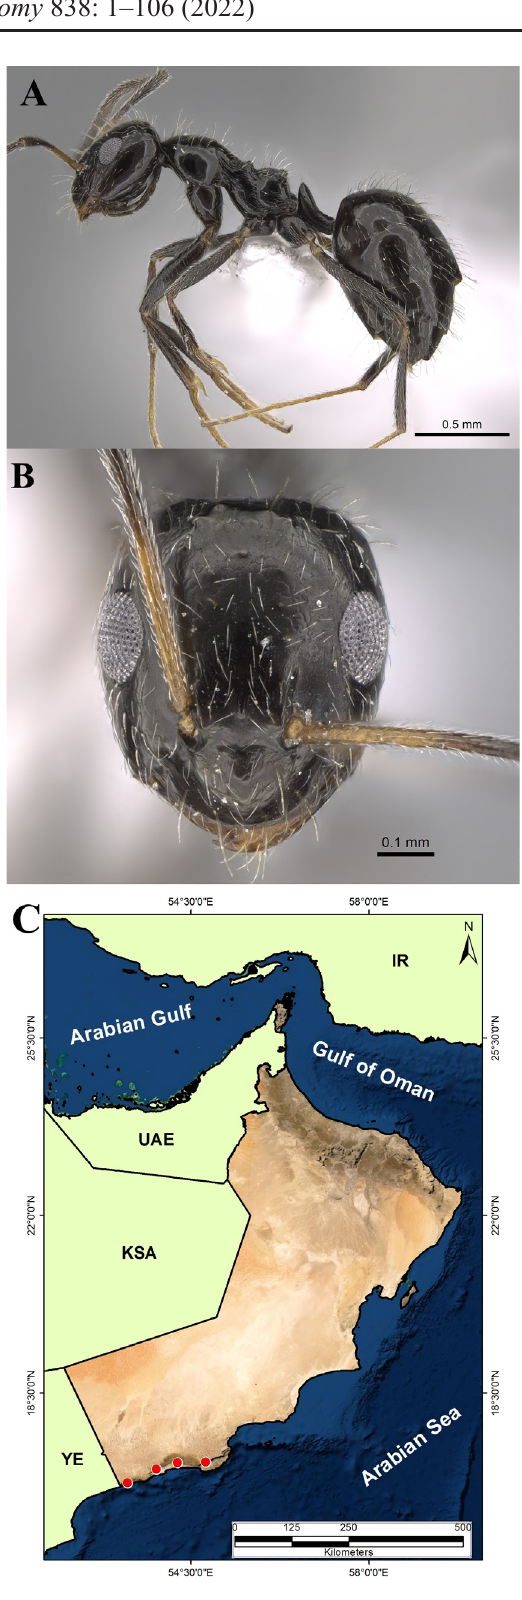
Fig. 15. Lepisiota canescens (Emery, 1897), worker (CASENT0922846, AntWeb.org (Michele Esposito)). A . Body in profile. B . Head in full-face view. C . Distribution